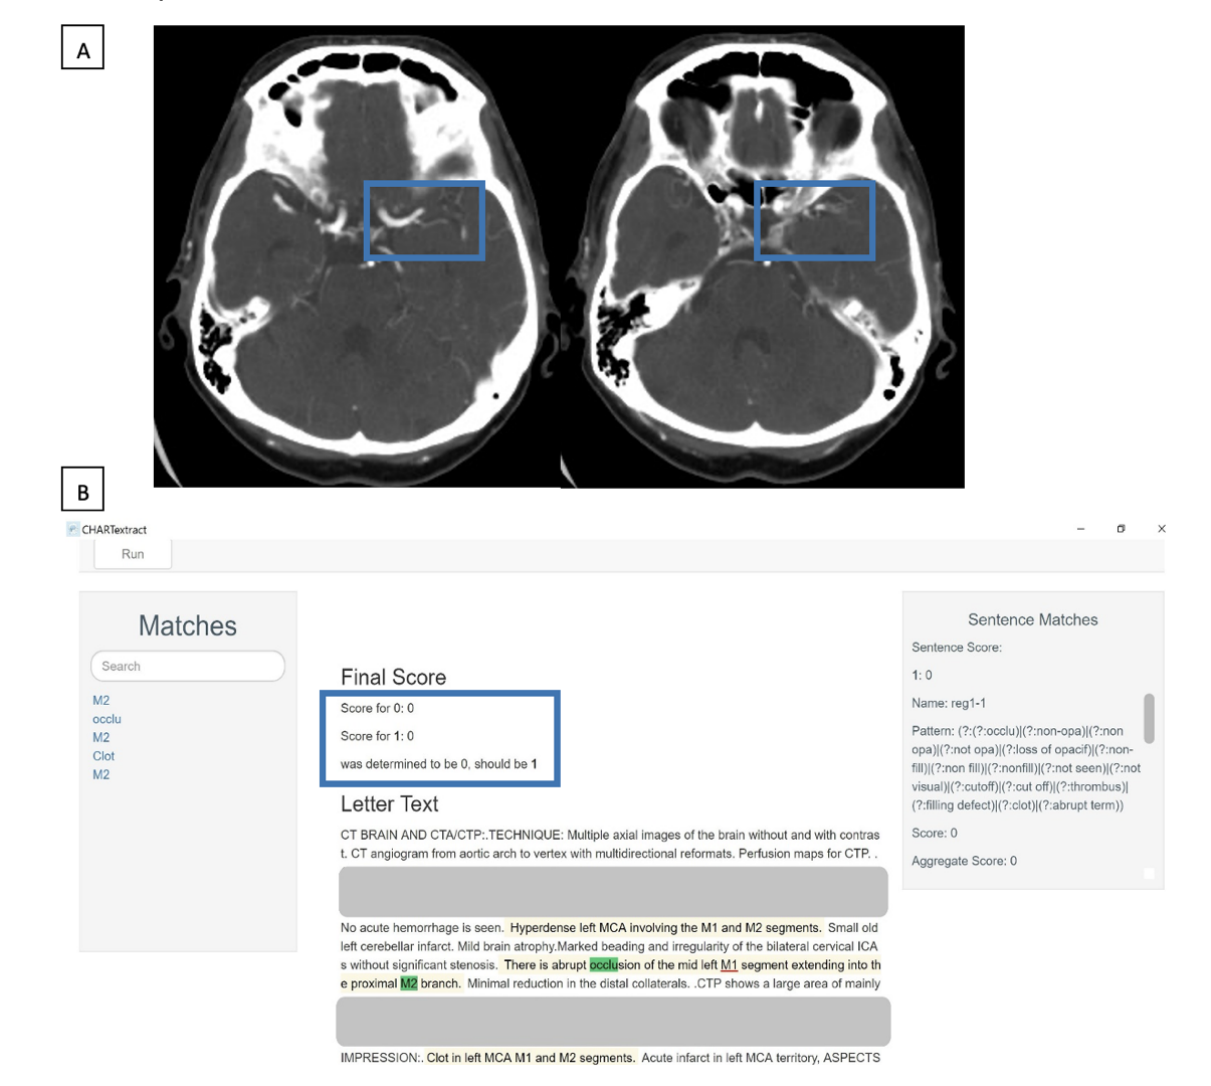
Figure 1. Example 1 of a discrepancy between the chart abstractor and CHARTextract tool output. (A) Computed tomography angiography scan showing loss of opacification in the left middle cerebral artery, involving the left M1 segment and extending into the M2 segment. (B) CHARTextract tool output: the chart abstractor labeled that large vessel occlusion was present, but the CHARTextract tool determined this attribute to be absent. The rules were revised to reflect that occlusion involving the “M1 segment” should be considered a large vessel occlusion even if the terms “MCA” or “middle cerebral artery” were